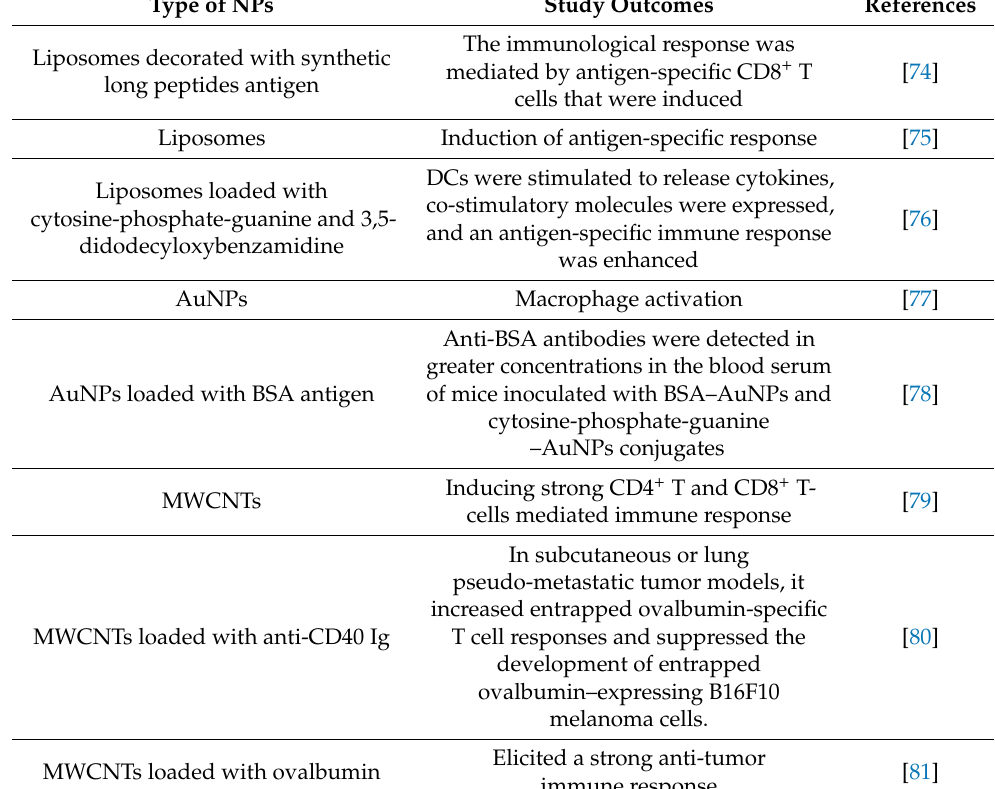
Table 2. NP-based immunostimulatory effect and study results from the studies outcome. Type of